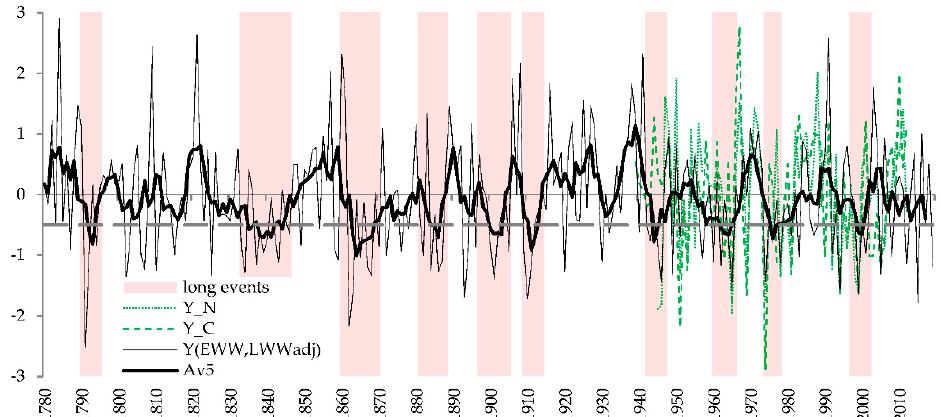
Figure 6. Reconstructed and actual crops yield (transformed in Z-scores): shaded areas represent 5+ year periods when average modeled yield is less then mean —0.5 SD threshold (grey dashed line); dotted and dashed lines represent actual crops yield in Northern and Central zones respectively; black lines represent model Y_N(EWW,LWW adj ) and its 5-year smoothed time-series.